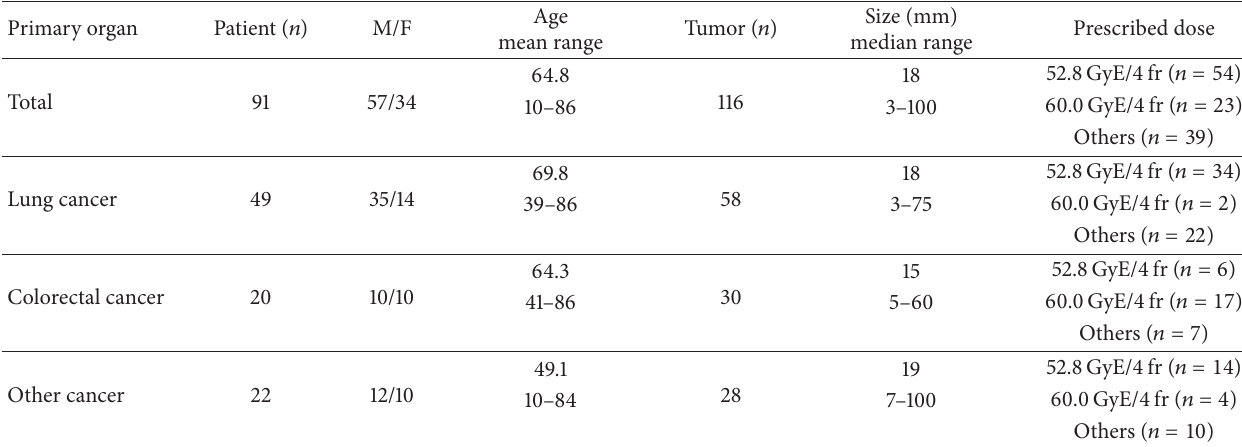
Table 1: Patient